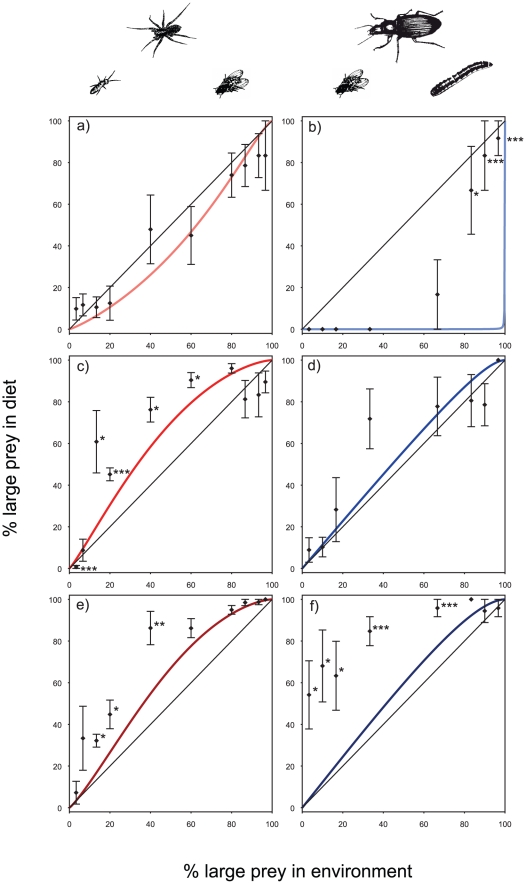
Two-prey consumption experiments for (a,c,e) spiders with Drosophila as large prey and Heteromurus as small prey, and (b,d,f) beetles with Drosophila as small and Alphitobius larvae as large prey.Solid black line indicates traditional null model of strictly density-dependent consumption, coloured lines show predictions of the allometric two-prey functional response model (see Fig. 3). Black diamonds show mean consumption in two-prey experiments, vertical bars indicate standard errors. T-test significance levels are indicated as: *<0.05, **<0.01 and ***<0.001. Panels show the results for a) Trochosa terricola juvenile, b) Anchomenus dorsalis, c) Pardosa lugubris, d) Calathus fucscipes, e) Trochosa terricola adult and f) Harpalus rufipes.